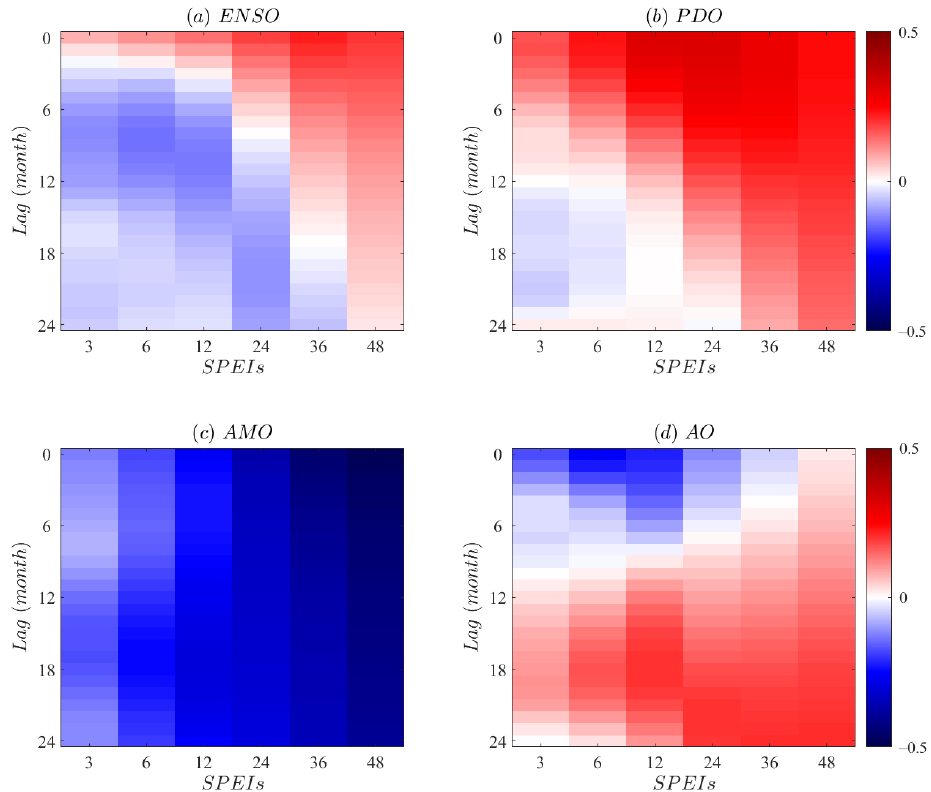
Figure 9. Cross-correlation coefficients of Xinjiang SPEIs to ( a ) ENSO, ( b ) PDO, ( c ) AMO, and ( d ) AO on 3-, 6-, 12-, 24-, 36-, and 48-month timescales, with variation in SPEI lagging teleconnections by 0-24 months. Horizontal axis denotes the SPEI on different timescales, and vertical axis denotes lag month (0–24). k value on vertical axis indicates that SPEI lags climate indices by k